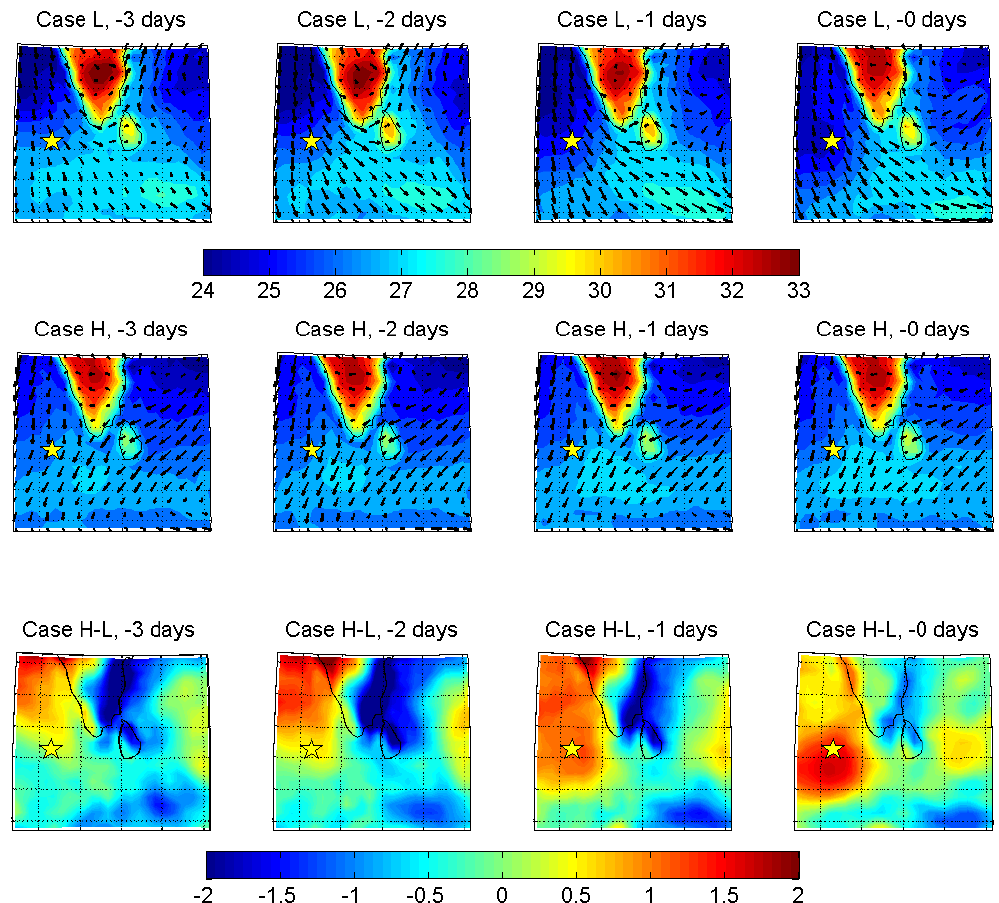
Figure A7. As in Fig. A6 but showing ECMWF 1000hPa temperature ( ◦ C) overlaid with average winds for the preceding 3 days and the day in question – Case L, Case H, or the difference (H −